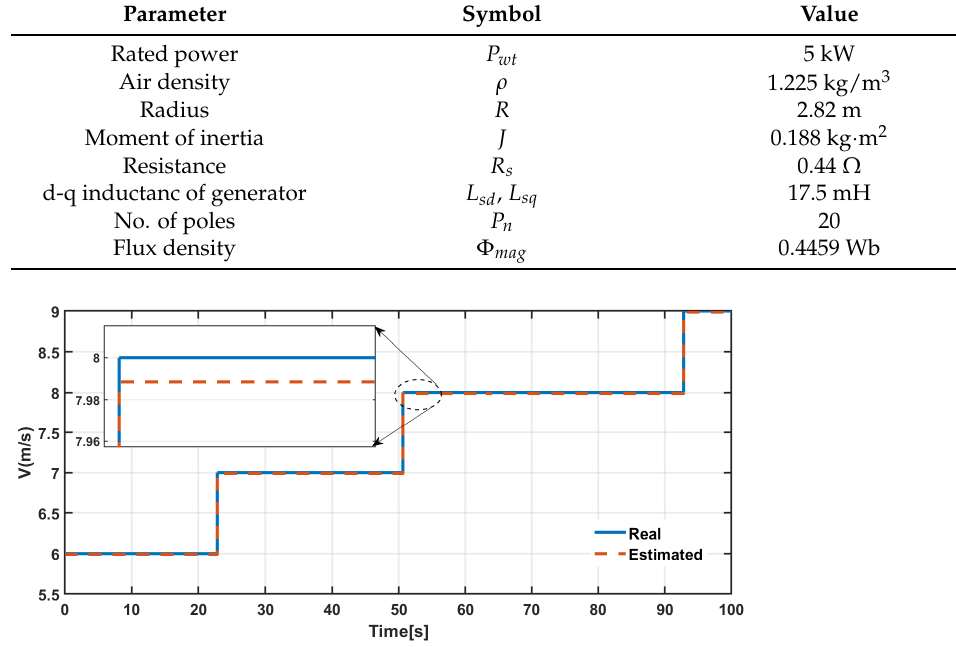
Table 1. Parameters of PMVG-based WECS [27].